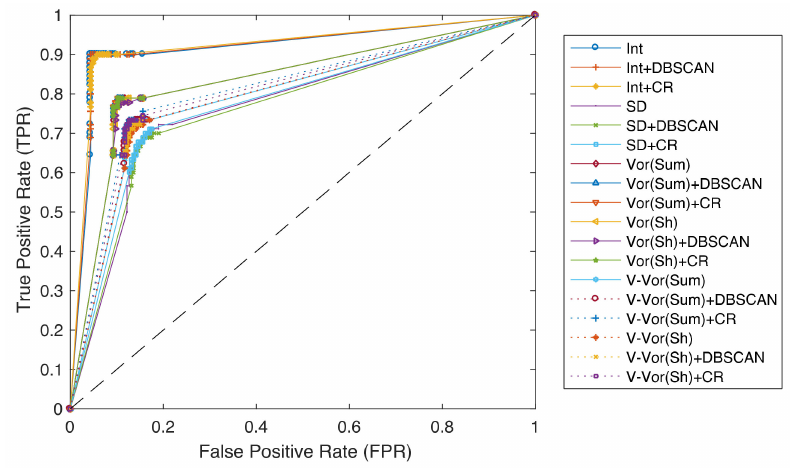
Figure 23. ROC curve of each model’s performance using top cell percentage for threshold settings.